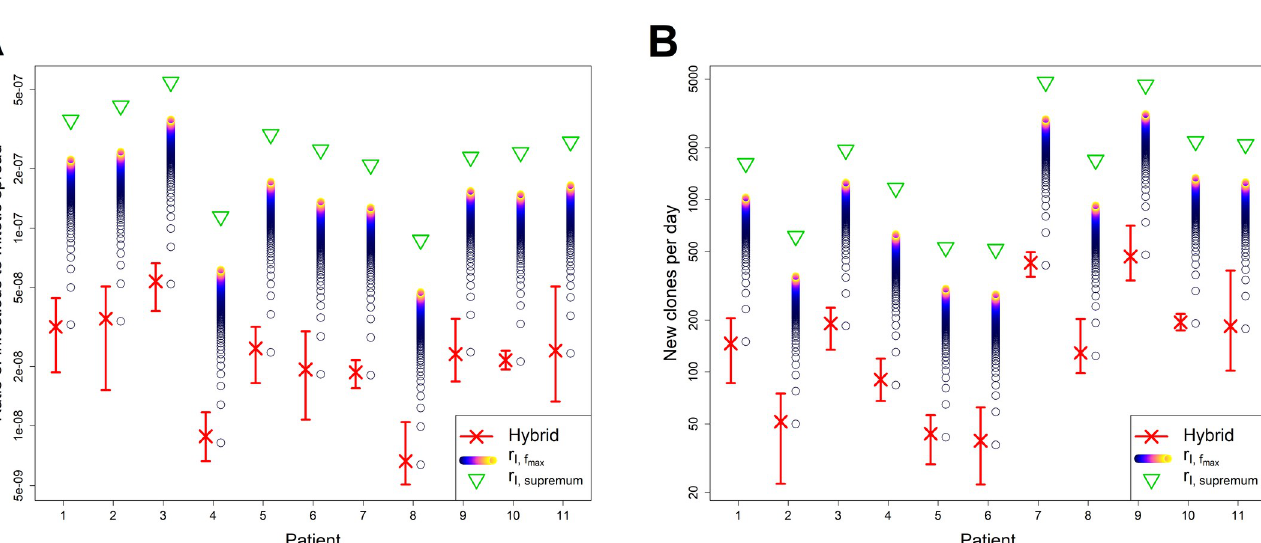
PLOS Computational Biology | https://doi.org/10.1371/journal.pcbi.1007470 September 17,